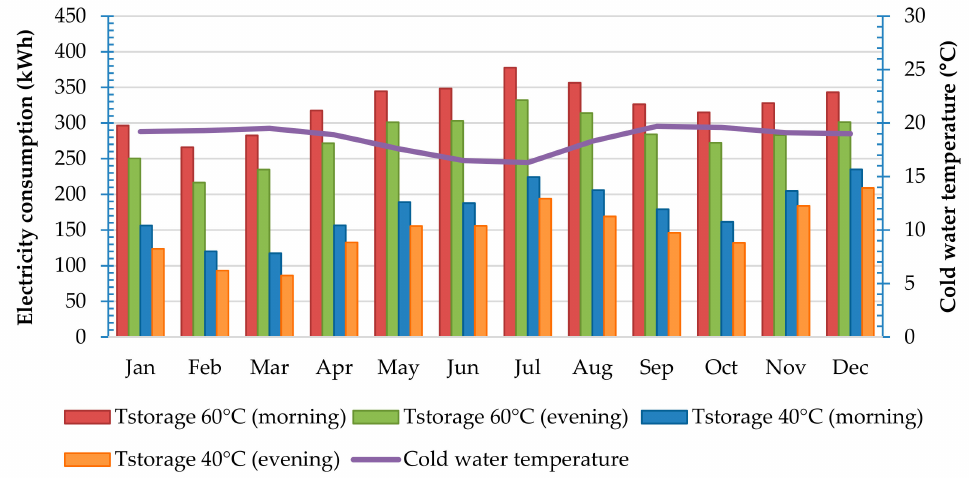
Figure 9. Electricity consumption using solar heating systems with a boiler in Bras í